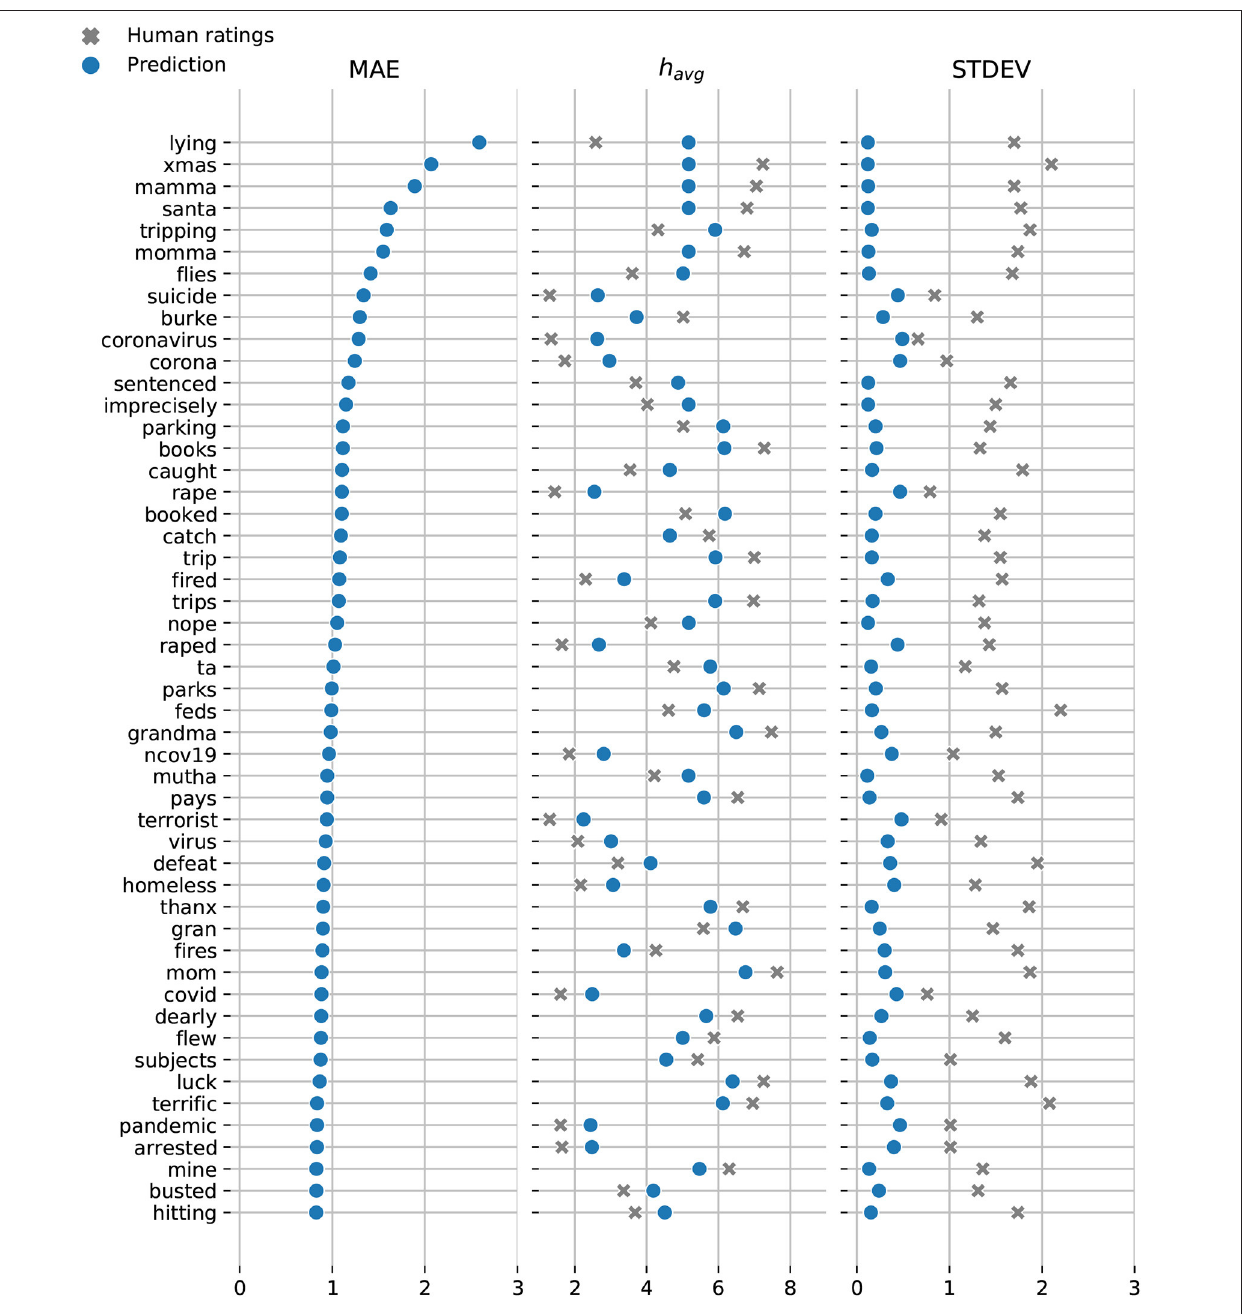
FIGURE 8 | Dictionary model: Top-50 words with the highest mean absolute error. Model predictions are shown in blue and the crowdsourced annotations are displayed in gray. Note, the vast majority of words with relatively high MAE also have high standard deviations of AMT ratings. Words that have multiple definitions will have a neutral score (e.g., lying). A neutral happiness score is also often predicted for words because we are unable to obtain good definitions for them to use as input. Although we have definitions for most words in our dataset, we still have a little over 1,500 words with missing definitions. Most of these words are names (e.g., “‘Burke,”) and slang (e.g., “xmas,” and